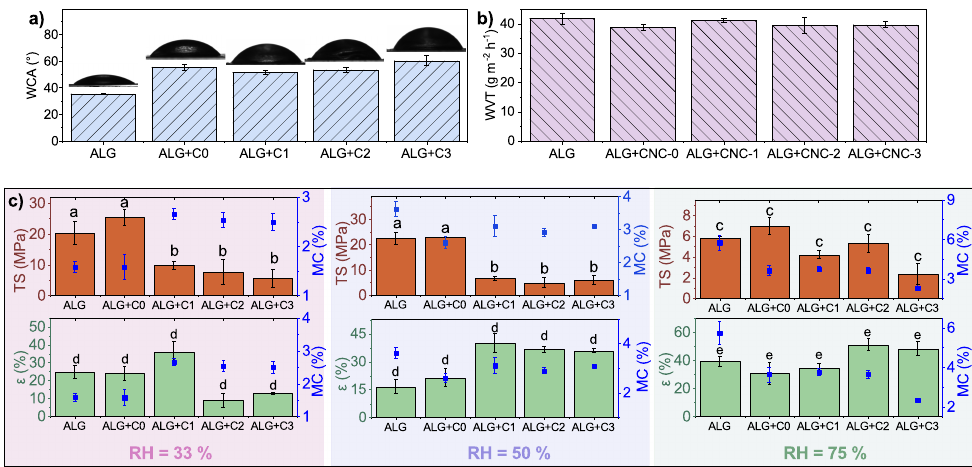
Figure 7. ( a ) Water contact angle (WCA), ( b ) water vapour transmission (WVT) and ( c ) mechanical properties with respect to environmental RH of alginate-based films, where different letters denote samples with significantly different mean value ( p <